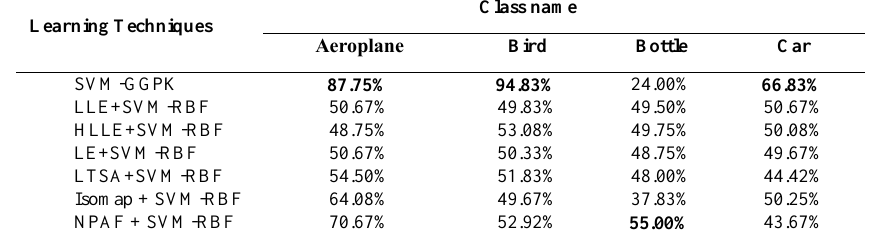
Table 8. Accuracy of SVM with RBF kernel trained on features extracted using LLE, HLLE, LE, LTSA, Isomap, and NPAF on subsets of PASCALVOC2012 dataset.